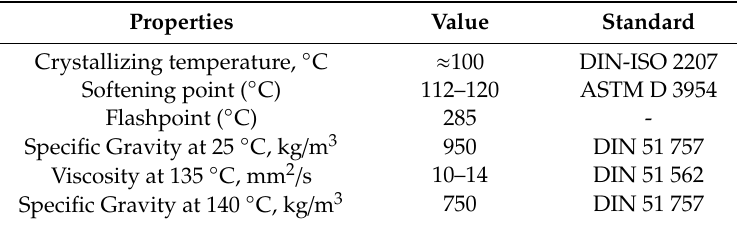
Table 3. Physical properties of